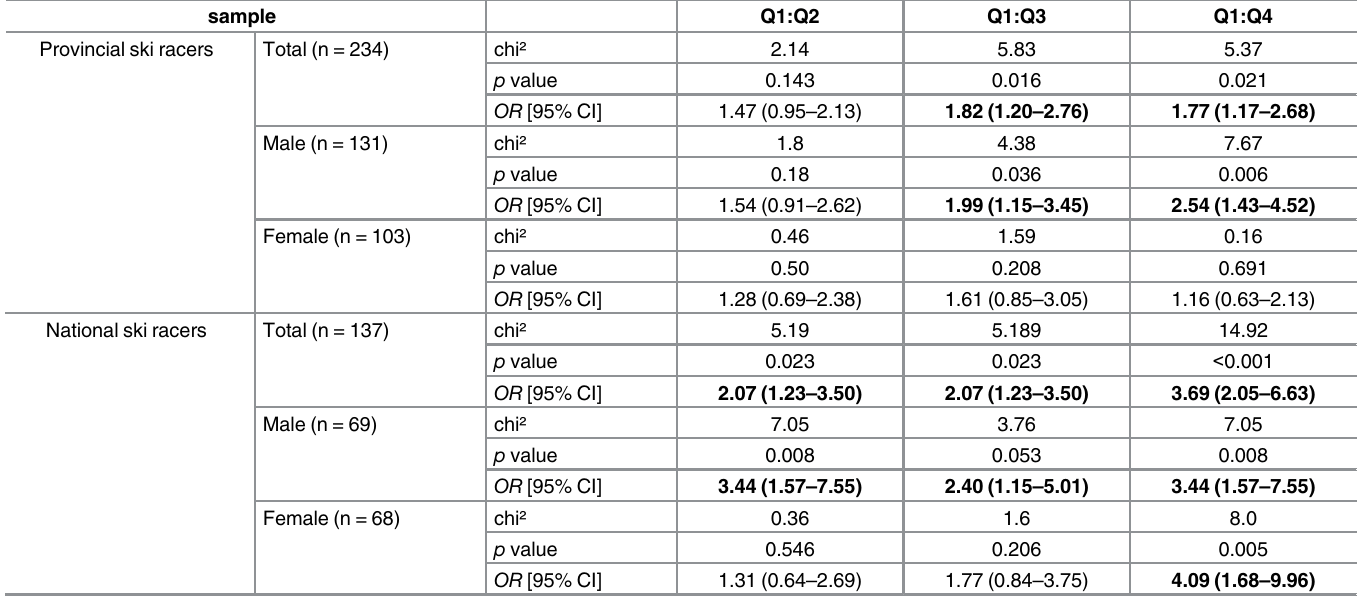
provincial and national ski racers are presented in Table 2. The descriptive OR and the corre- sponding χ ² for each quarter of the provincial and national ski racers are presented in Table 3. The OR calculations revealed significant differences in the total sample of provincial ski racers and among the male provincial ski racers between relative age quarter 1 and 3 and between the first and the last relative age quarter. The likelihood of participation in provincial races of a male athlete of the first relative age quarter was 2.5 times higher than for one of the last quarter. Among the female provincial ski racers no significant differences were found. Among the national ski racers significant differences were found already between athletes of the first and the second relative age quarter for the total sample and the male athletes. Among the female national ski racers, a significant difference was found between athletes of the first and the last relative age quarter with a 4.1 times higher likelihood of selection for female athletes of the first